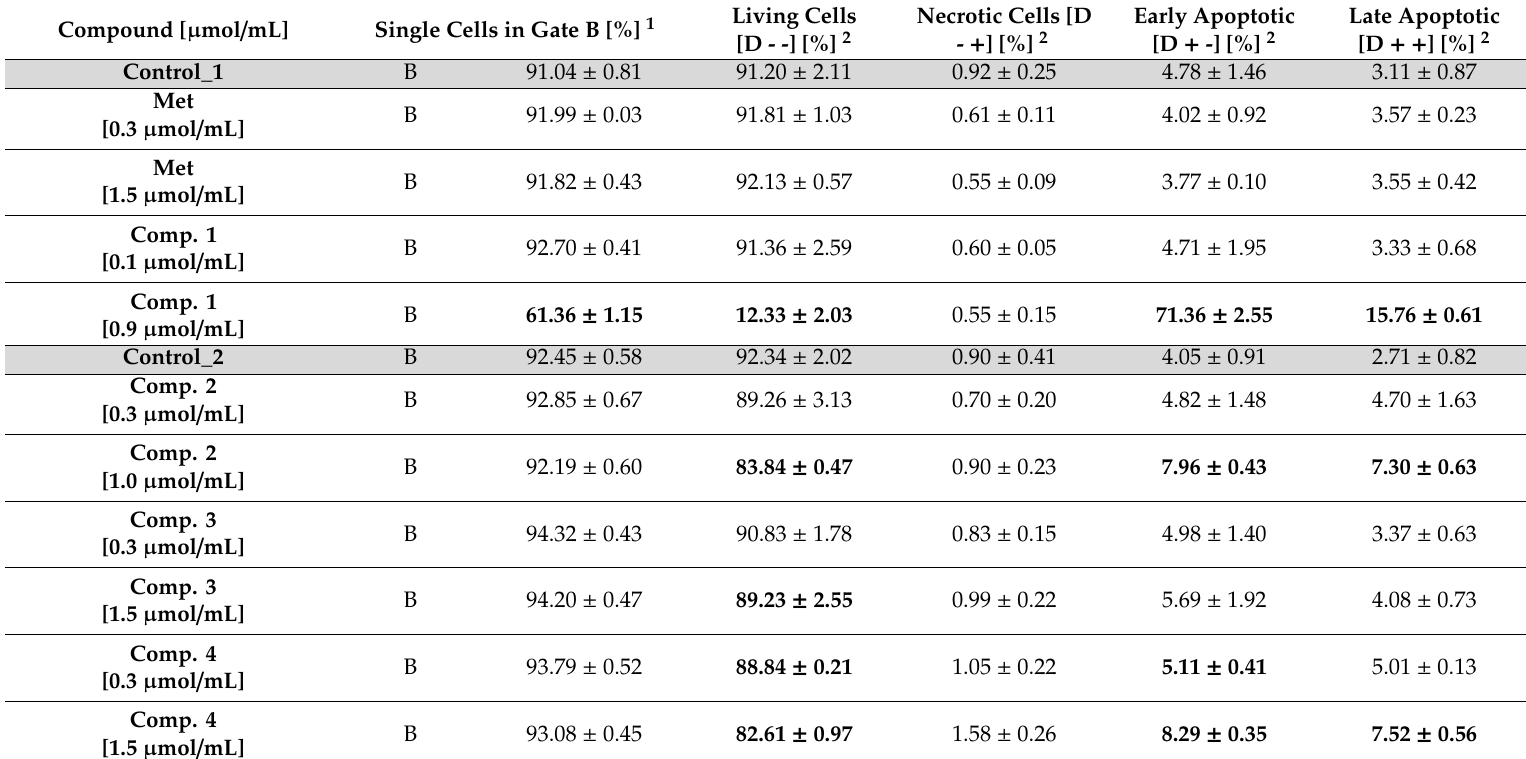
Table 2. Annexin V-FITC / PI double staining analysis of apoptosis in